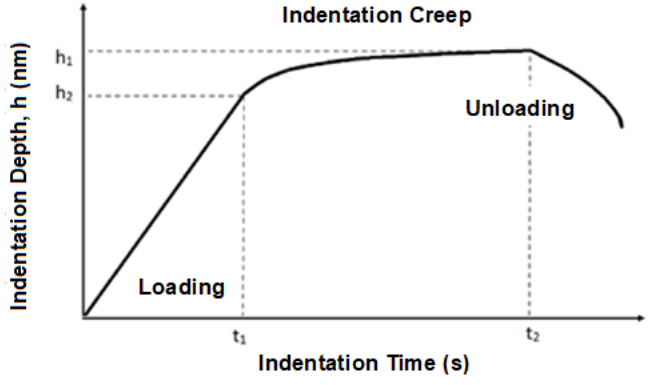
Figure 2. Indentation creep.